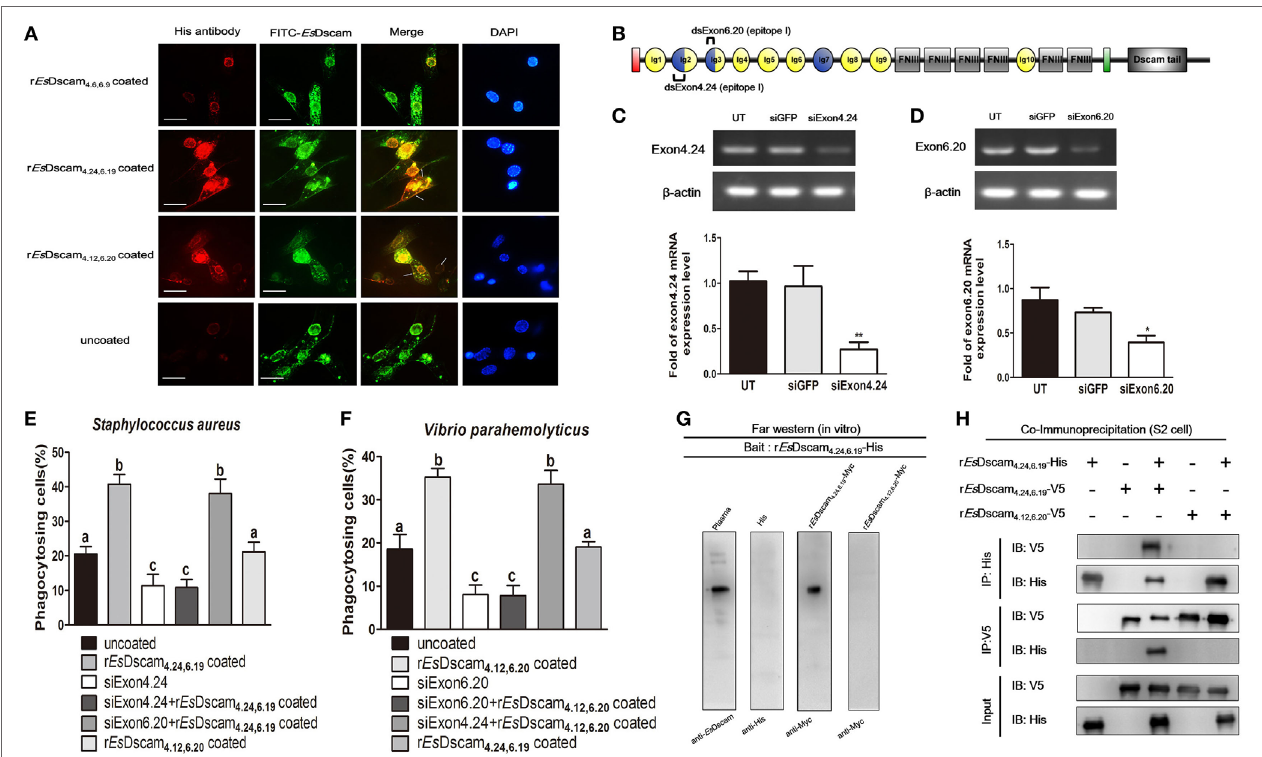
FigUre 8 | Interaction of membrane-bound and soluble Es Dscam is essential for promotion of phagocytosis. (a) Colocalization of Es -mDscam and Es -sDscam in hemocyte surface. Each group that including r Es Dscam 4.6,6.9 , Staphylococcus aureus coated r Es Dscam 4.24,6.19 , and Vibrio parahemolyticus coated r Es Dscam 4.12,6.20 was used to stimulate cultured crab hemocyte. Hemocytes were collected 1 h later and subjected to immunocytochemistry detected by the antibodies of Es Dscam (membrane-bound Es Dscam) and His-tag (soluble Es Dscam). Scale bar = 15 µm. Data are representative of two independent repeats. (B) Schematic diagram showing the RNAi region recognized by siExon 4.24 and siExon 6.20 primers in the epitope I region. (c,D) Knockdown of exon 4.24 and exon 6.20 expression. Crab hemocyte were transfected with 5 nM exon 4.24 siRNA ( left panel ) or exon 6.20 siRNA ( right panel ), with equal amounts of GFP siRNA served as a control. RNA samples were collected at 24 h post-transfection to check the silencing efficiency by RT-PCR with β -actin as a reference. RT-PCR data are representative of two independent repeats. At least three crab were used for each sample, and qRT-PCR were performed three times. The results are expressed as the mean ± SD, data were analyzed by Student’s t -test. ** p < 0.01, * p < 0.05. (e,F) Specific membrane-bound Es Dscam regulate soluble Es Dscam promoted phagocytosis in hemocyte. Rate of hemocyte phagocytosis of (e) Staphylococcus aureus and (F) V. parahemolyticus following knockdown of exon 4.24 and exon 6.20, respectively. Phagocytic rates of hemocytes were calculated according to the formula presented in Section “Materials and Methods.” At least 15 fields were included and data represent the mean ± SD of three independent experiments. The results were analyzed statistically using one-way ANOVA and the letters (a, b, c) presented significant differences ( p < 0.05). (g) Interaction between membrane-bound and soluble Es Dscam in vitro . The bait protein r Es Dscam 4.24,6.19 -His was first separated by SDS-PAGE, transferred onto a nitrocellulose membrane, and renatured by adding a series of different concentration of guanidine-HCl. The undetected proteins were added to recognize the bait protein on the membrane before the attached proteins were detected by Western blotting using the specific antibodies. Data are representative of two independent repeats. (h) Interaction between membrane-bound and soluble Es Dscam in vivo . Lysates from S2 cells transiently transfected with pAc5.1-r Es Dscam 4.24,6.19 - His, together with pAc5.1-r Es Dscam 4.12,6.20 - V5 or pAc5.1-r Es Dscam 4.24,6.19 - V5, were subjected to immunoprecipitation with anti-His Ab or anti-V5 Ab, followed by Western blot analysis with anti-His Ab and anti-V5 Ab. The input controls were also analyzed by Western blot. Data are representative of two independent